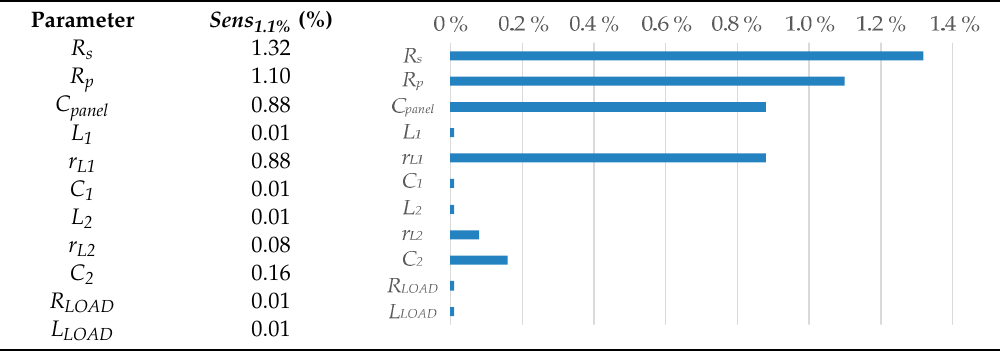
Table 8. Sensitivity in case of perturbation equal to 1.1 times the optimal parameter value.